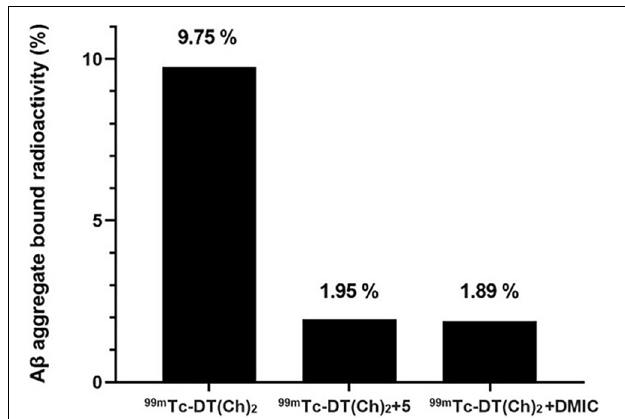
FIGURE 6 | Binding and blocking assay of 99m Tc–DT(Ch) 2 with A β 42-plaques ( n = 5). The binding is represented as %radioactivity bound to the A β 42